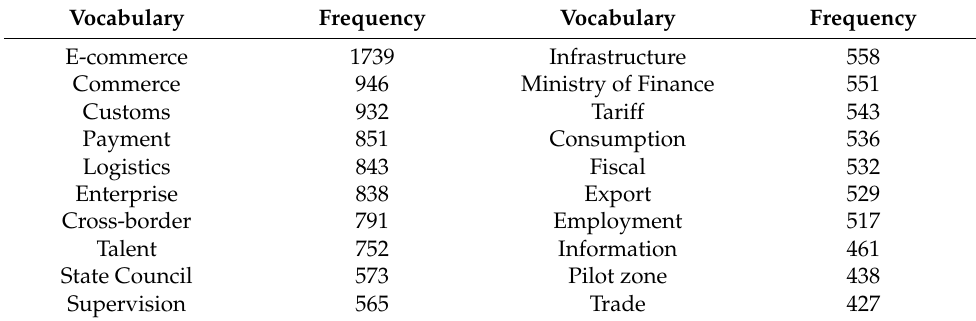
Table 2. High-frequency